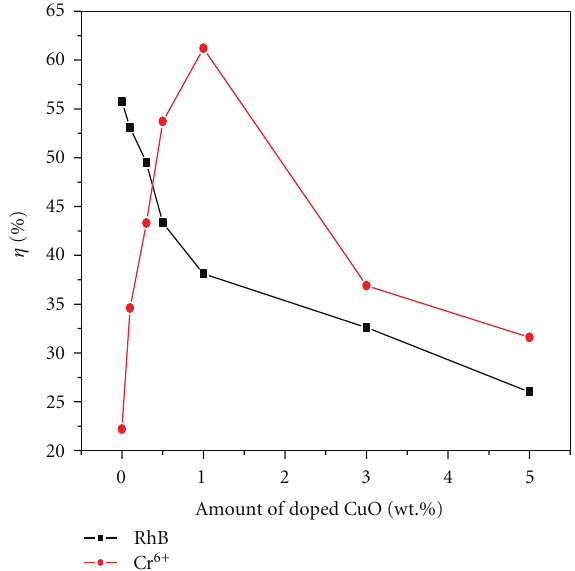
Figure 6: E ff ect of the amount of NH 4 F on the photocatalytic reduction of Cr 2 O 72 − and photocatalytic oxidation of RhB.